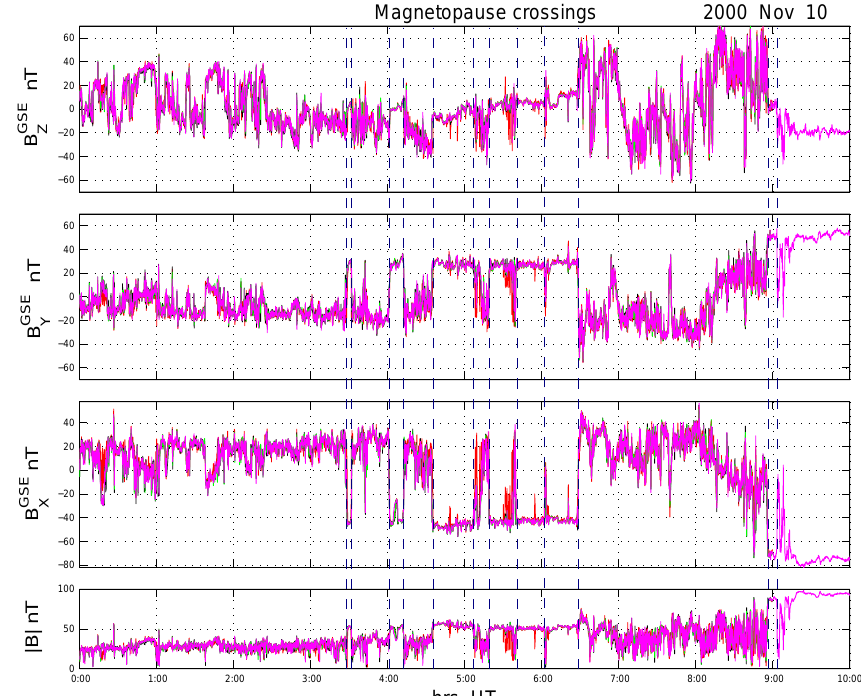
Fig. 1. Four-spacecraft, calibrated FGM data taken on 10 November 2000. The data are expressed in GSE coordinates and the field magnitude is given in the bottom panel. The spacecraft traces are represented as individual colours (s/c1-black, s/c2-red, s/c3-green, s/c4-magenta), but normally these are hidden when the spacecraft see the same field. Inter-spacecraft comparisons show that the calibrated data agree in absolute terms to within ± 0 . 2nT. Small scale structure, or temporal changes, between the spacecraft appear as deviations between the traces. The spacecraft are in the magnetosheath at the start of the day. An extended encounter with the magnetopause, resulting in a series of crossings (indicated by dashed vertical lines), occurs between 03:30–06:30 UT. Following this, a large compression of the magnetosphere results in an extended period of magnetosheath, followed by a final re-entry into the magnetosphere. The key magnetopause crossings are